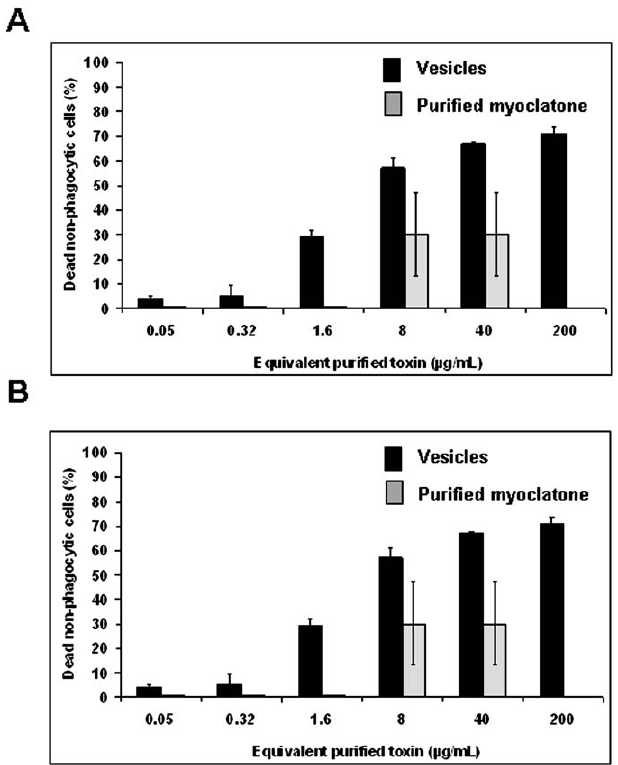
Figure 7. Cytotoxicity of Vesicles Comparative cytoxicity of vesicles (black bars) and purified mycolactone (grey bars) on phagocytic cells (bone marrow–derived mouse macro- phages, [A]) and non-phagocytic cells (Cos cells, [B]). The mycolactone associated with vesicles is more cytotoxic than purified mycolactone.